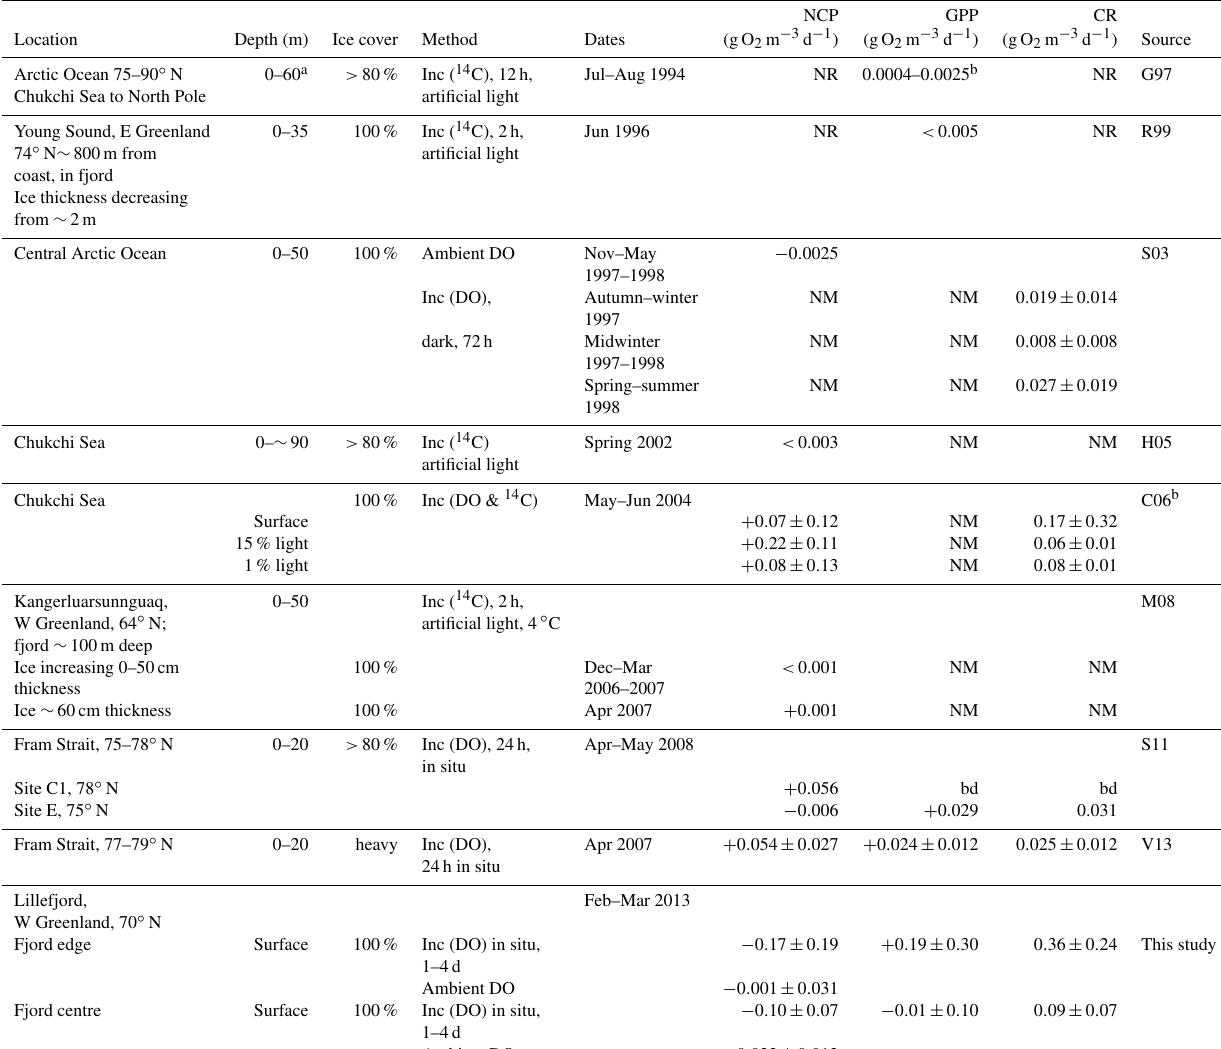
Table 1. Measurements of microbial metabolism under Arctic sea ice. Net community production (NCP) and gross primary production (GPP) are positive if oxygen is being released. Community respiration (CR) is positive if oxygen is being